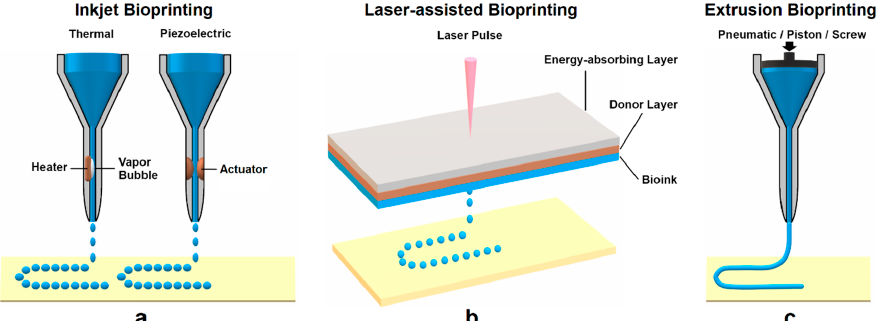
Figure 1. Common bioprinting techniques: ( a ) Inkjet bioprinting uses an electric heater